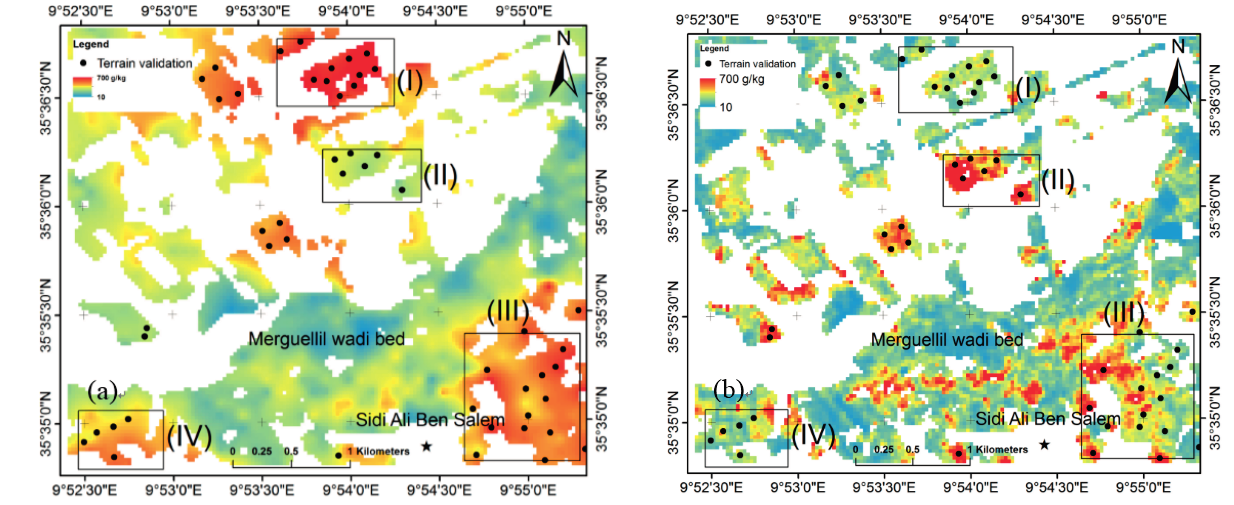
Figure 9. ( a ) Extract of the clay content map produced by Landsat TM data (2009). ( b ) Clay content map produced by TerraSAR-X data over only bare soil areas (2010). Black dots are the field observation in January 2015. Black frames are the compared sub sites.